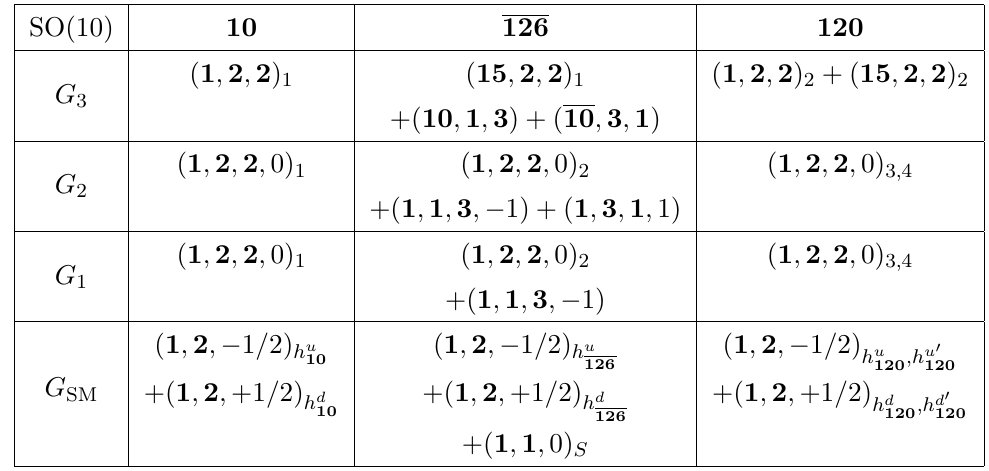
Table 4 . Decomposition of Higgses responsible for the fermion mass generation. 126 is the same Higgs as shown in table 2 and it is responsible for both the breaking G and right-handed 1 → G SM neutrino mass generation. ( 1 , 1 , 0) is the same singlet given in table S